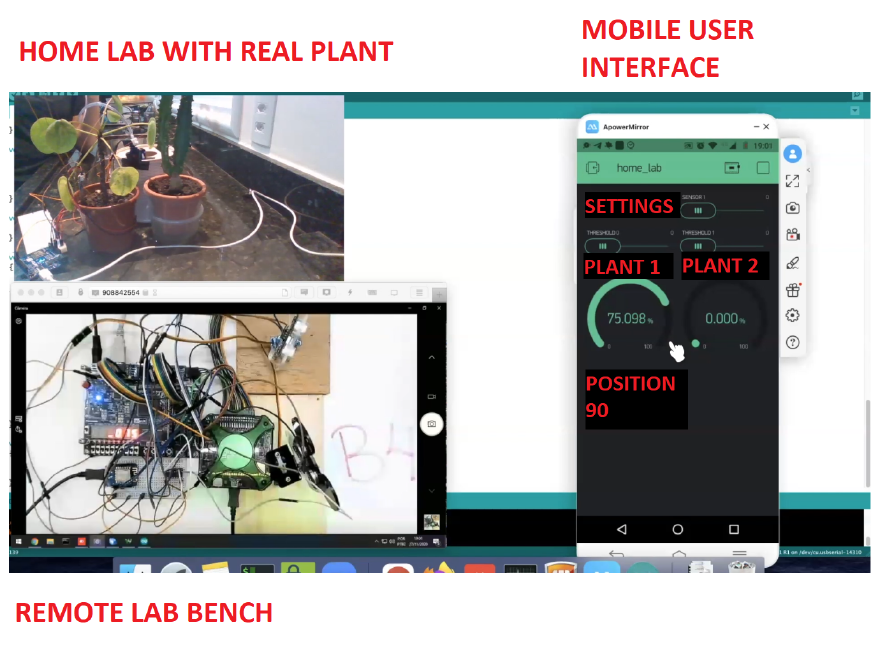
Figure 7. Smart Watering project.